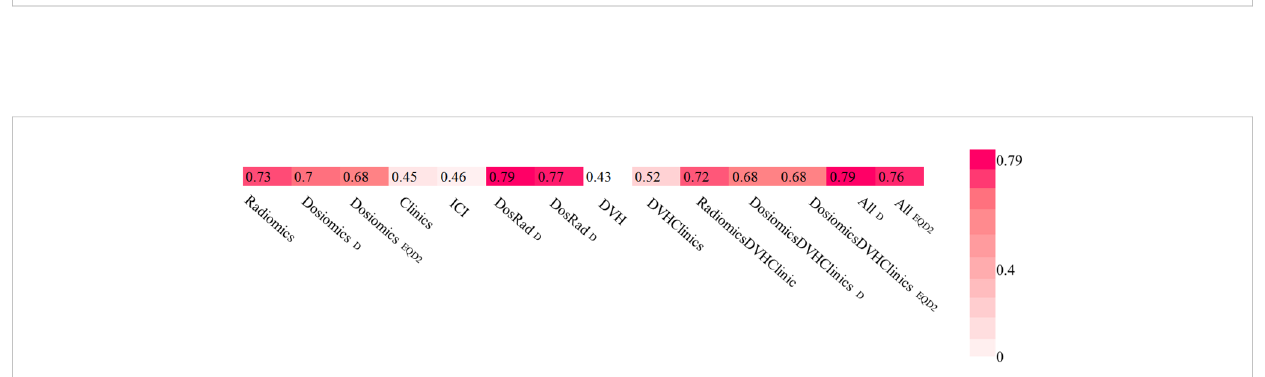
FIGURE 5 Area under the receiver operating characteristic curves (AUCs) heat maps as prediction substitute for PTP for physical Dose and EQD2 using random forest classi fi er and logistic regression for single feature models.